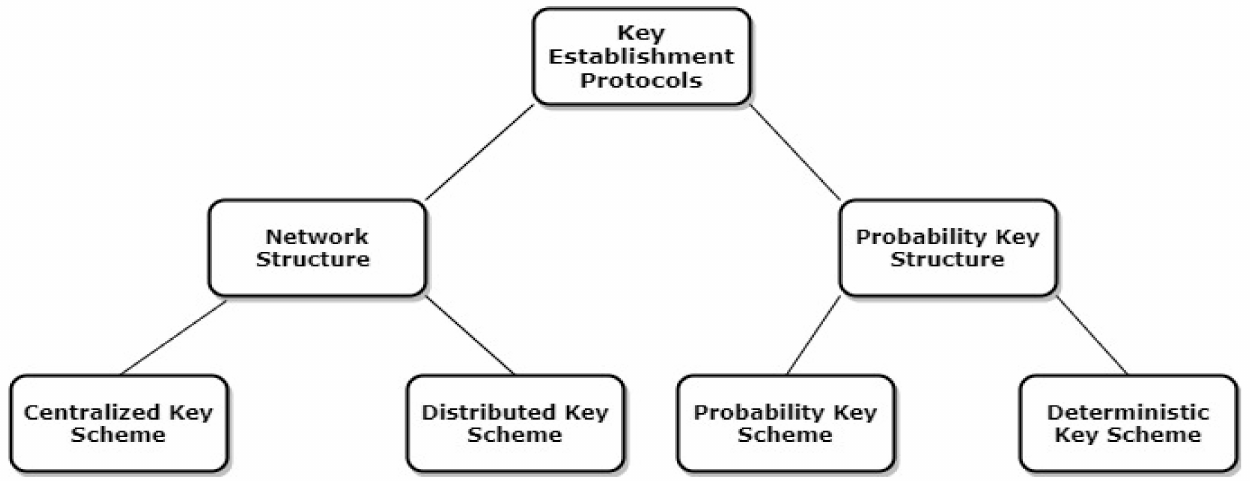
Figure 3. Key establishment protocols.